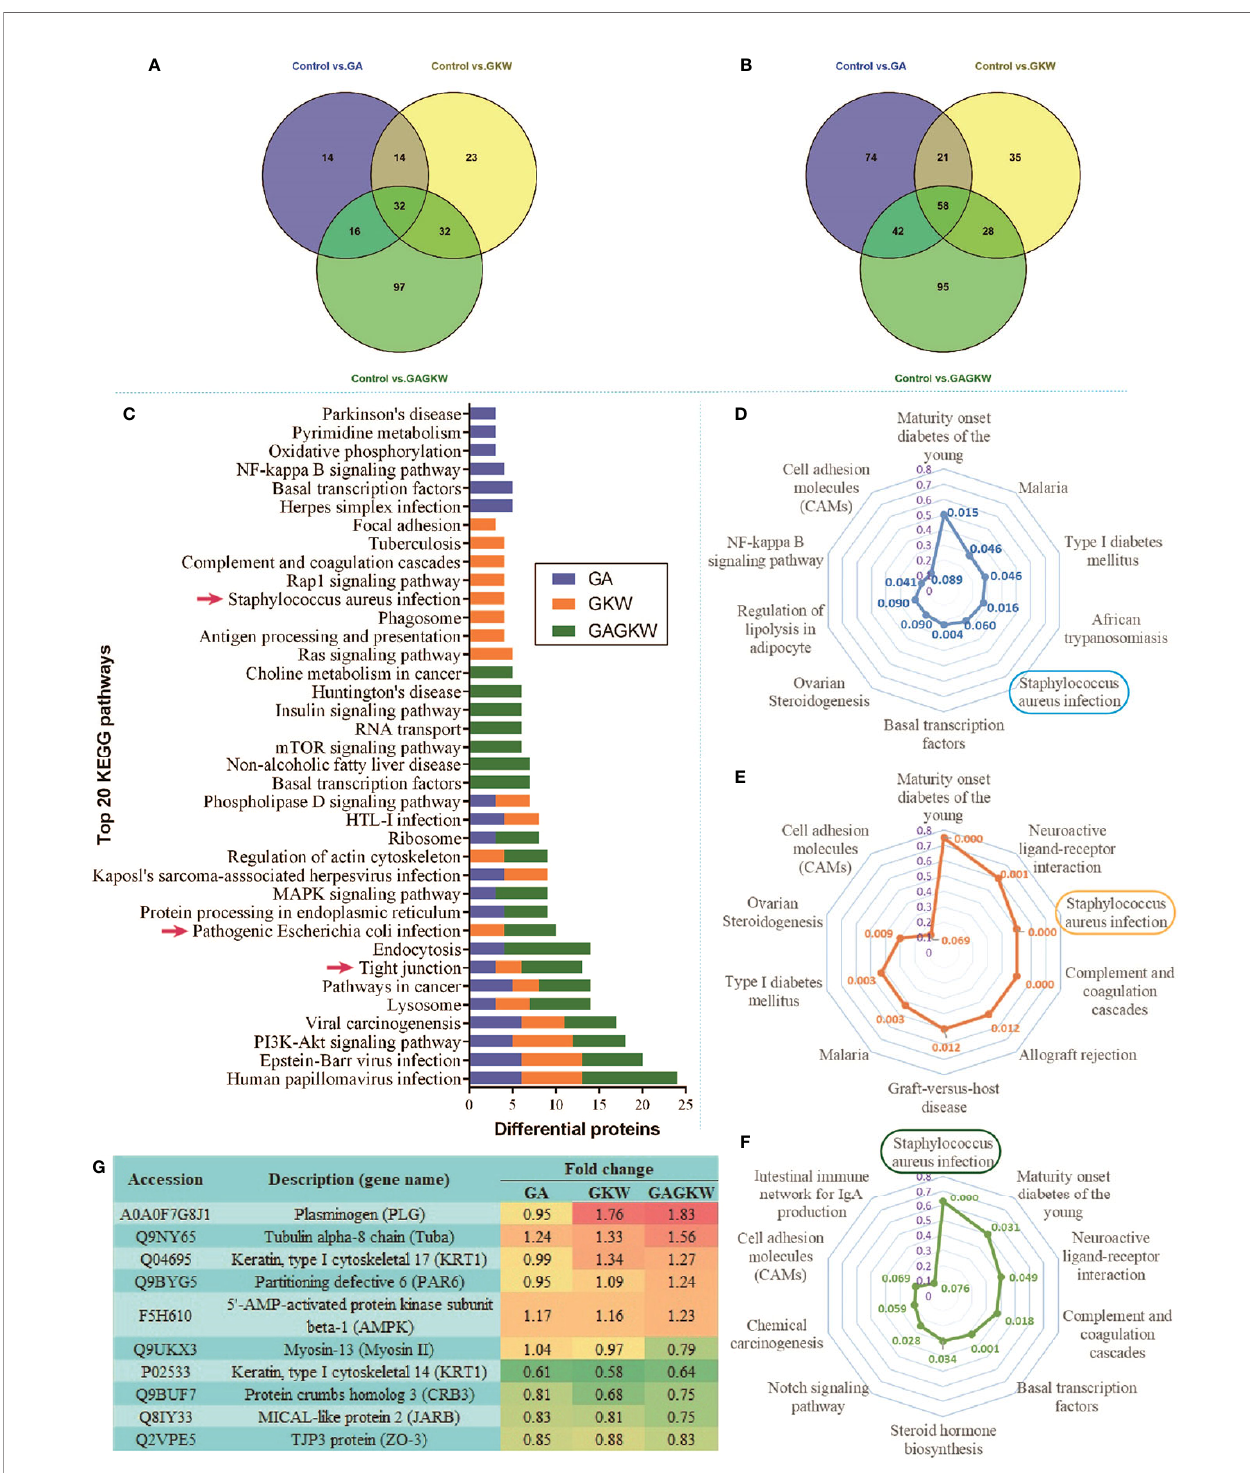
FIGURE 7 | iTRAQ-labeled proteomic study in LS174T cells treated by GA, GKW, and GAGKW. (A) Venn diagram of upregulated proteins treated by GA, GKW, and GAGKW. (B) Venn diagram of downregulated proteins treated by GA, GKW, and GAGKW. (C) Top 20 KEGG pathways regulated by GA, GKW, and GAGKW. Red arrows indicate pathogen infection pathways and the tight junction pathway. (D – F) Radar maps of KEGG pathway enrichment for GA, GKW, and GAGKW treatment, respectively. The maximum number for enrichment factor (purple axis) is set at 0.8, and p-values for each pathway are given beside pathway nodes. (G) Fold changes of proteins involved in the Staphylococcus aureus infection pathway and tight junction